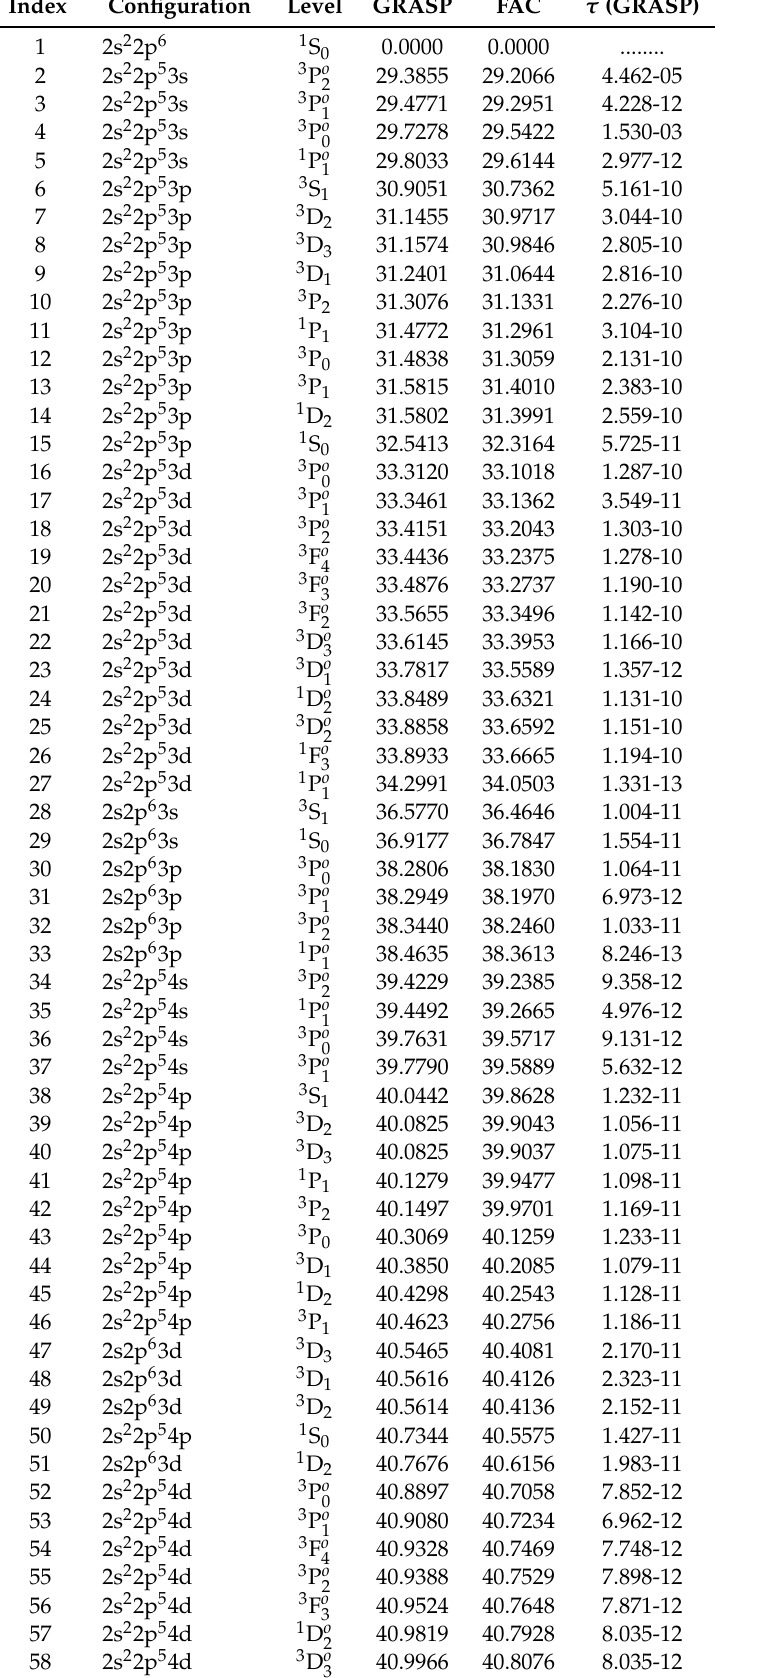
Table 2. Energies (in Ryd) and lifetimes ( τ , s) for the lowest 125 levels of Sc XII. a ± b ≡ a × 10 ± b